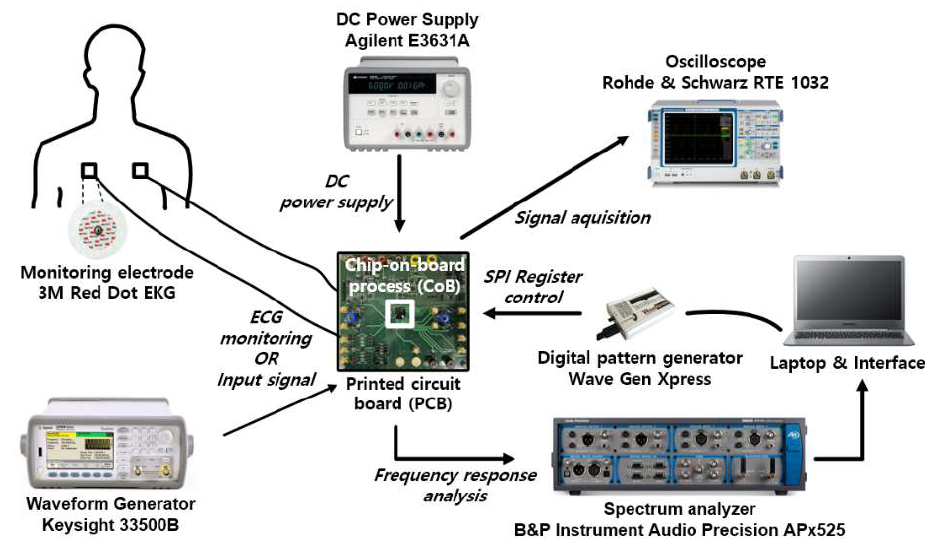
Figure 13. Measurement setup of the proposed ECG recording circuit.